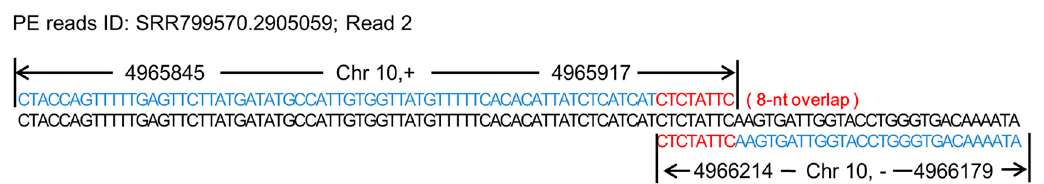
Figure 1. A chimeric read with the two segments located on the complementary strands and an 8-nucleotide (nt) overlap. The chimeric read is 101 base pairs (bp) in length. The two segments are mapped to the different strands of chromosome 10 and have an 8-nt overlap. In the sense strand, the sequences of the 8-nt overlap in the two locations are reverse complementary sequences; CTCTATTC and GAATAGAG. The sequence of segments are drawn in red and blue, and the red parts are the sequences of overlap.